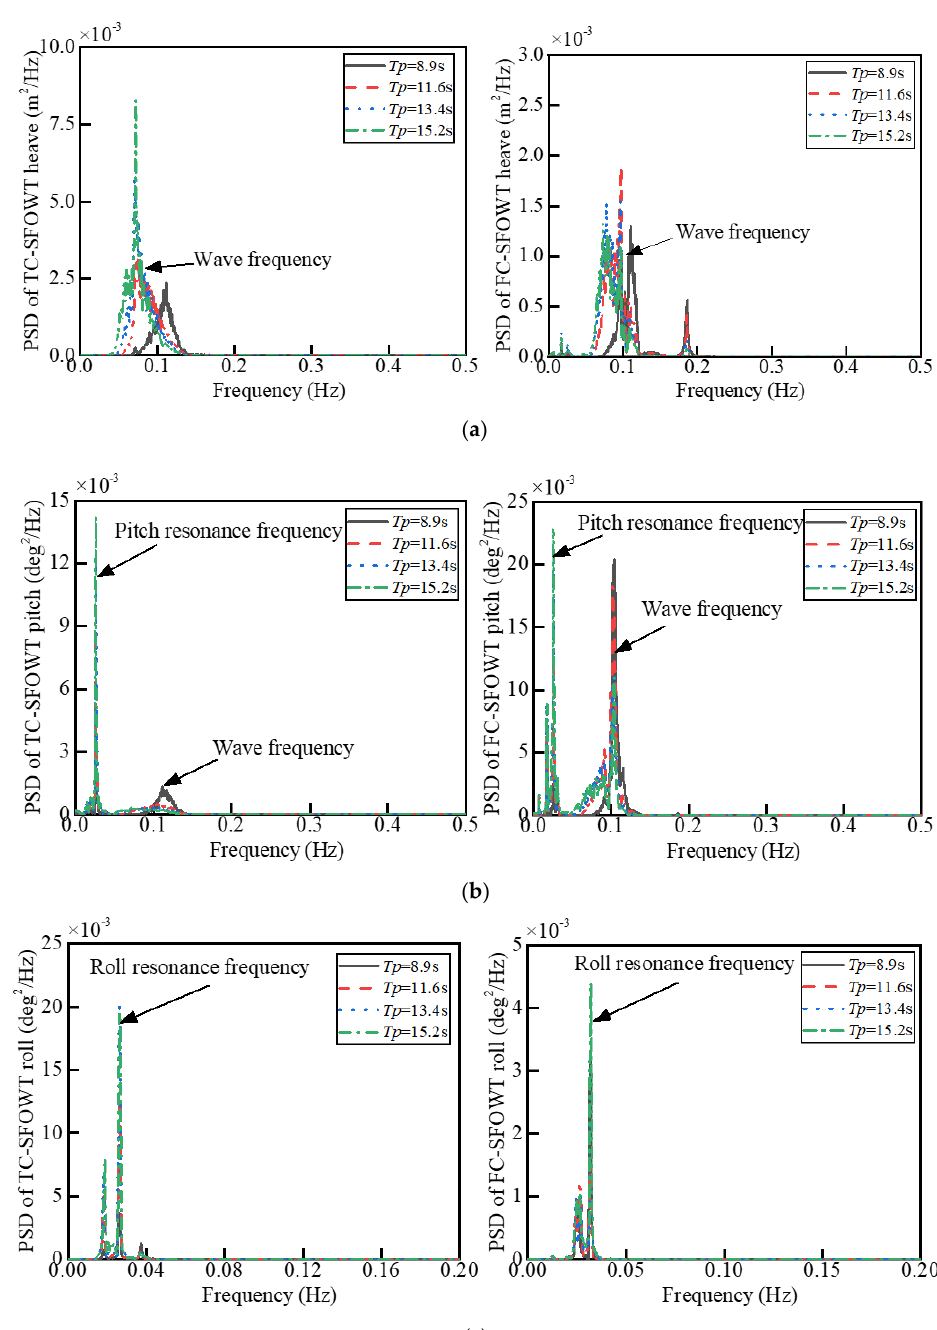
Figure 17. Power spectra of the SFOWT motion under different wave period conditions ( Hs = 5 m). ( a ) Heave motion, ( b ) pitch motion, ( c ) roll motion.